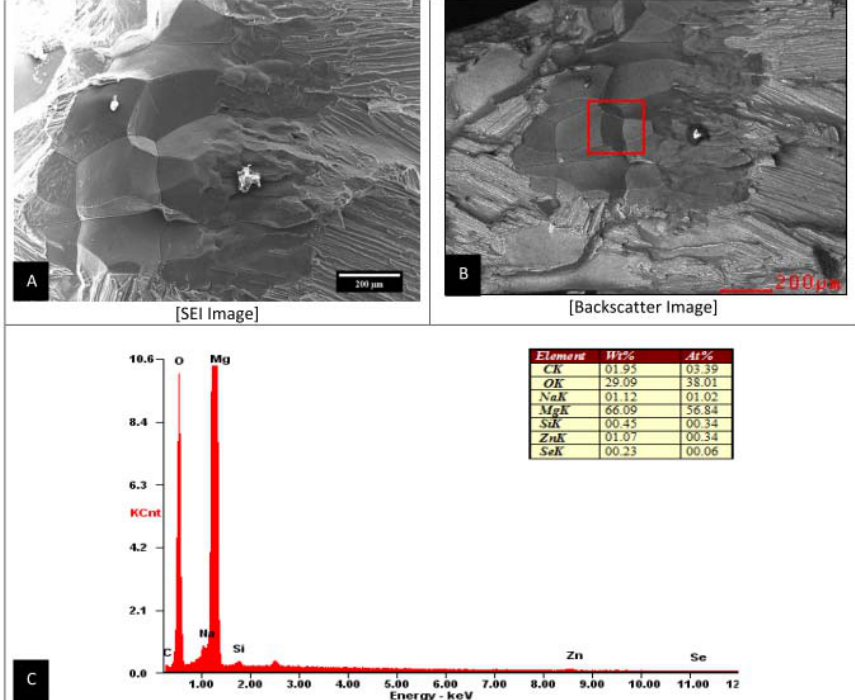
Figure 6. Mg-Zn-Se alloy casting defect in tensile specimen leading to premature